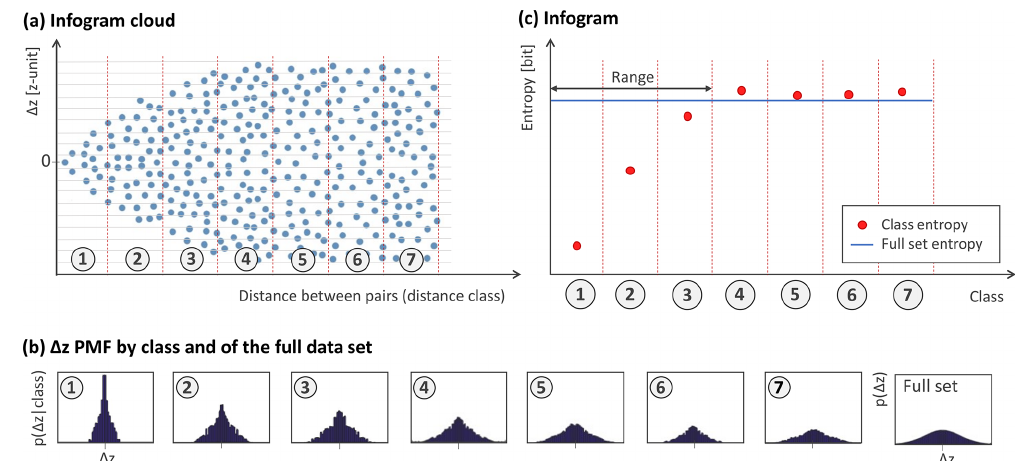
Figure 2. Spatial characterization. Illustration of (a) infogram cloud, (b) (cid:49)z probability mass functions (PMFs) by class, and (c)